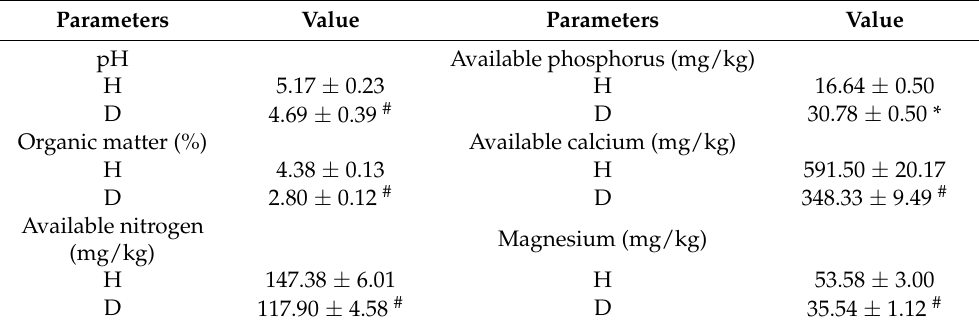
Table 2. The pH and chemical properties of healthy and diseased bayberry rhizosphere soil.